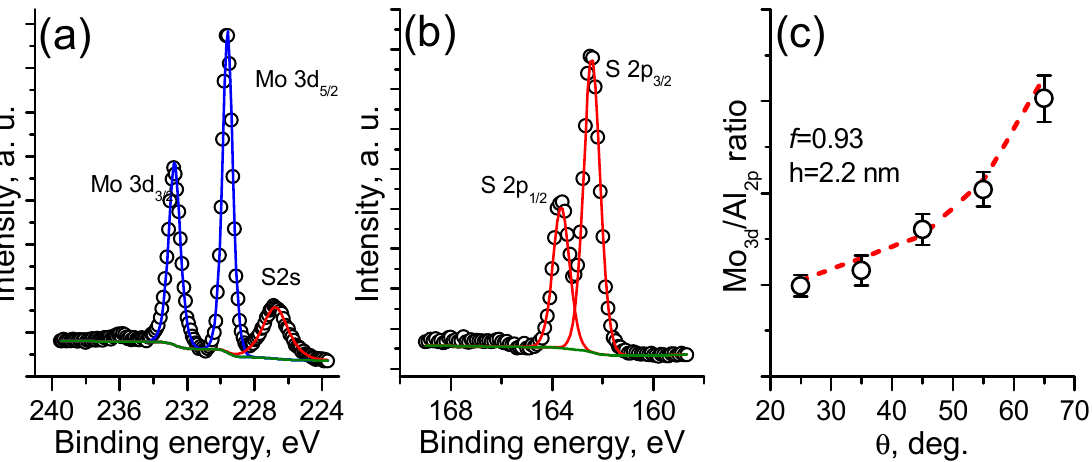
Figure 2. Mo3d ( a ) and O1s ( b ) XPS spectra of the initial MoO 3 film. The XPS analysis carried out immediately after sulfurization (Figure 3a,b) revealed that the Mo3d spectrum is described by a single doublet with the binding energy of the Mo3d 5/2 line of approximately 229.6 eV, which corresponds to the Mo 4+ state in MoS 2 [27]. In addition, no peaks corresponding to the state of Mo being bonded with oxygen ions are observed, suggesting the complete conversion of the MoO 3 to Mo-sulfide. The corre- sponding S2p spectrum consists of a single doublet with the binding energy of the S2p 3/2 line at 162.4 eV, which coincides with the stoichiometric MoS 2 . The quantitative XPS anal- ysis based on Mo3d and S2p sensitivity factors showed that the film stoichiometry was S/Mo ≈ 2.1 for the given sulfurization conditions. In order to estimate the obtained MoS 2 thickness and continuity, the XPS spectra corresponding to the film and substrate were collected in the angle-resolved mode (Figure 3c). According to our previous work, such a procedure possesses sufficient accuracy [31]. It was found that the best fitting experi- mental data correspond to a continuous film (f ≈ 0.93) with a thickness of ≈ 2.2 nm (3–4 MoS 2 monolayers).